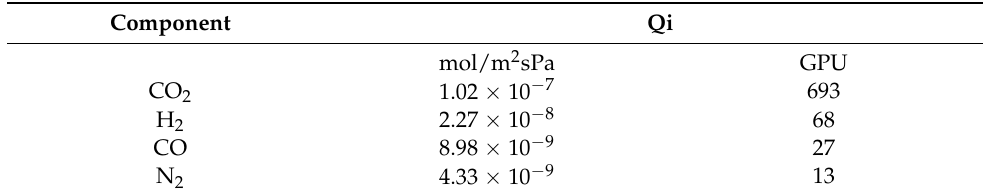
Table 4. Membrane permeance data at T = 30 ◦ C used in the system study.